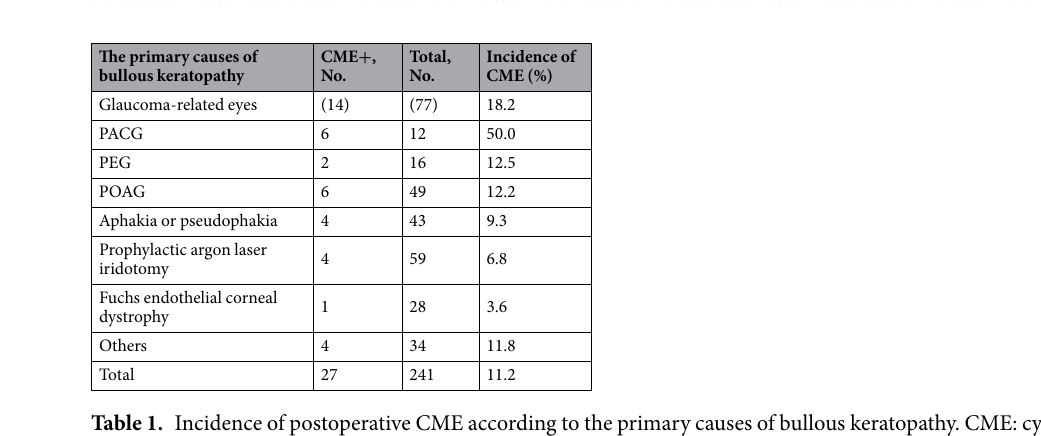
Figure 1. Flow chart illustrating the inclusion and exclusion criteria in this prospective study.